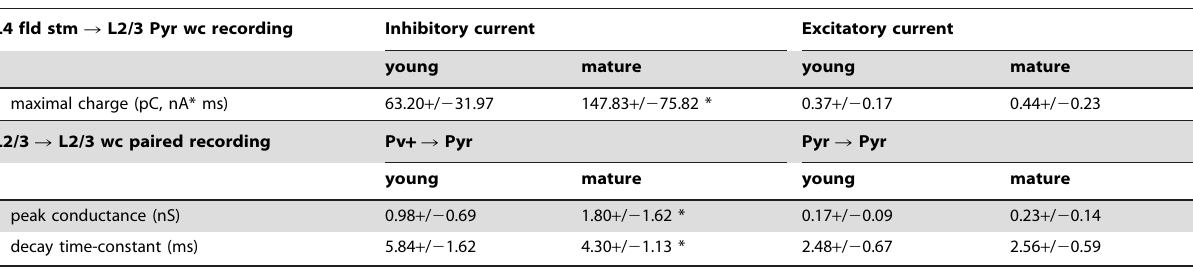
Table 1. Synaptic properties of layer 2/3 neurons of V1.